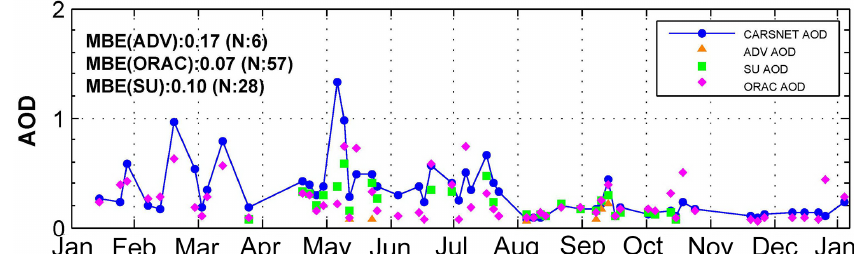
Figure 12. Time series comparison of AATSR AOD with CARSNET AOD at Dunhuang in 2008.